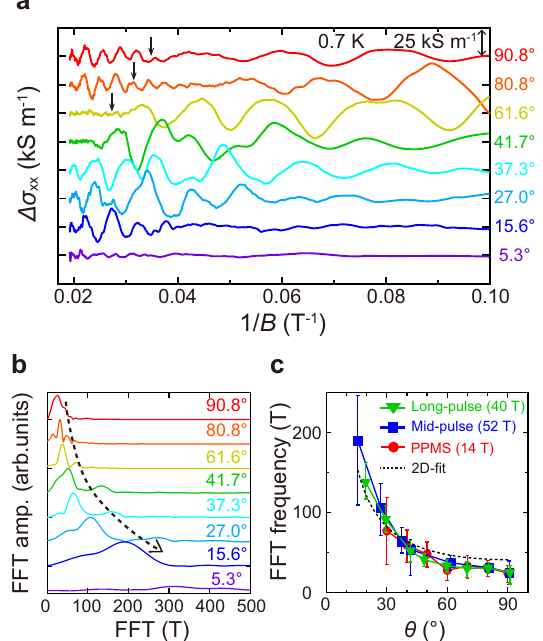
Fig. 6 Angular dependence of the SdH oscillations for the SrRuO 3 fi lm with t = 10 nm using the mid-pulse magnets. a Angular dependence of the background-subtracted SdH oscillations at 0.7 K with B (10 T < B < 52 T) for the SrRuO 3 fi lm with t = 10 nm, measured by the mid-pulse magnet. These spectra were smoothed (see the Sec. III of the supplementary information). The arrows indicate the quantum limit, which is the inverse value of the FFT frequency in c . b Angular dependence of the FFT spectra of SdH oscillations at 0.7 K for the fi lm with t = 10 nm. The dashed line is a guide for the peak shift. c Angular dependence of the FFT frequency. Here, the data obtained by the long-pulse magnet are also shown. The dashed line is the fi tting of a two-dimensional angular dependence (~1/ cos(90° − θ